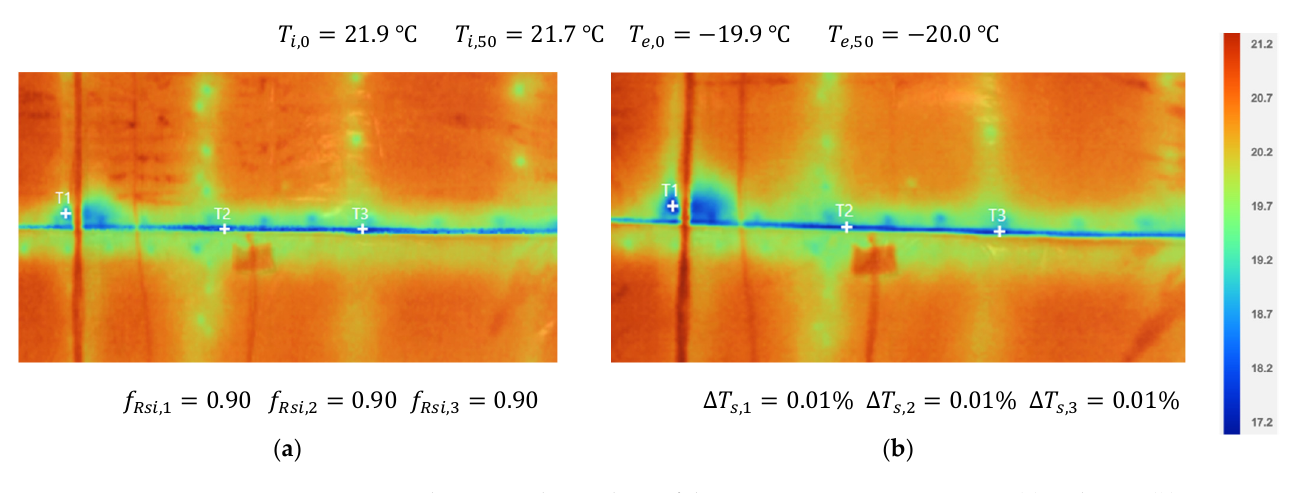
Figure 8. Thermographic analysis of the new concept 1 system at 0 Pa ( a ) and 50 Pa ( b ).